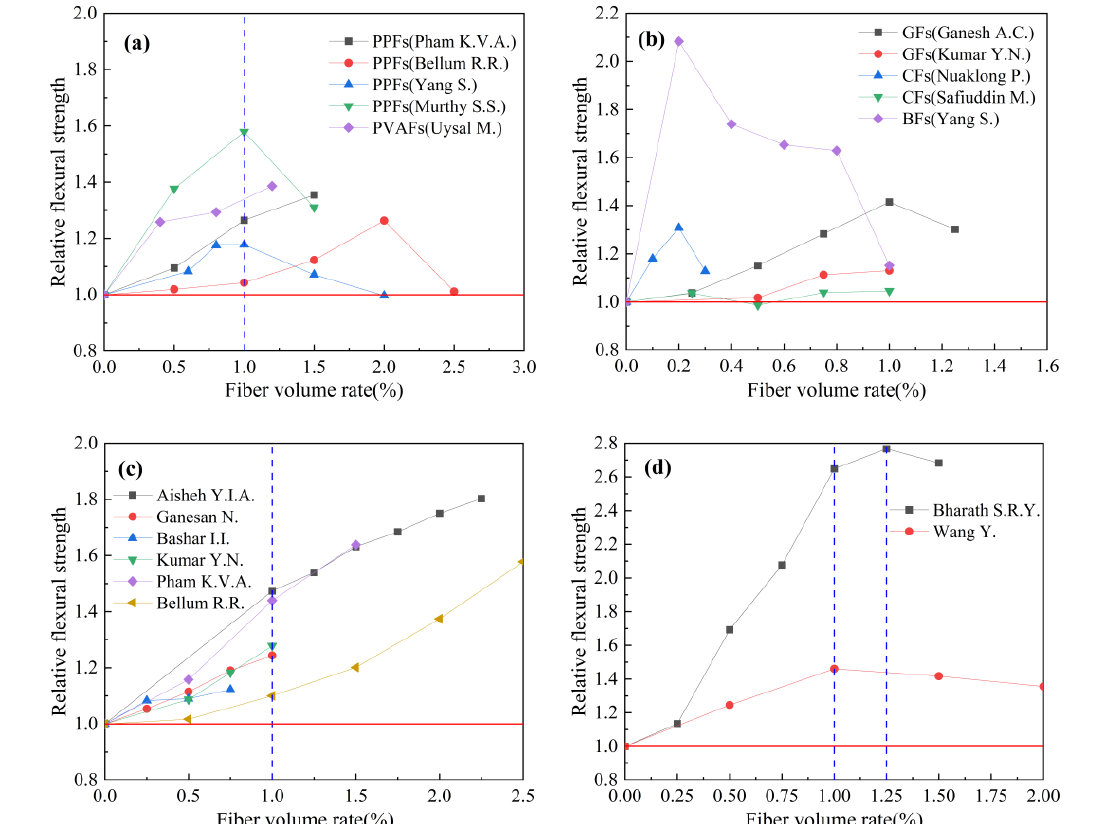
Figure 23. The effect of fiber volume rate on flexural strength: ( a ) Synthetic fiber; ( b ) inorganic fiber; ( c ) steel fiber; ( d ) plant fiber.